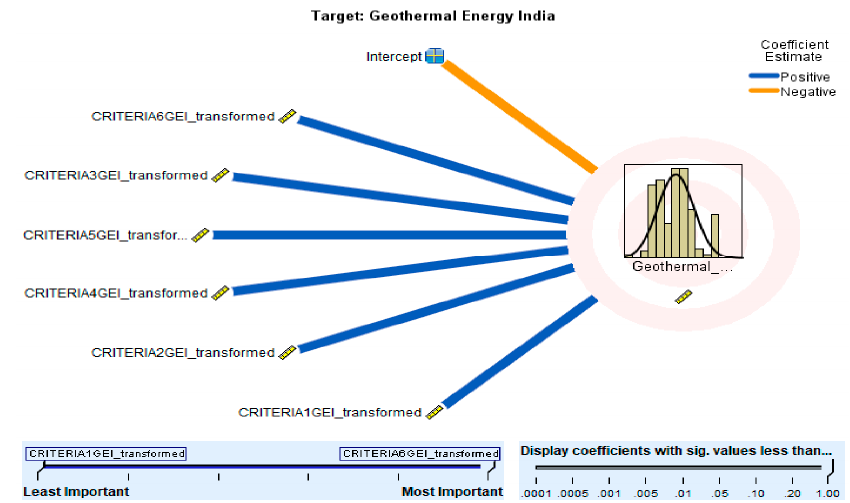
Figure 13. GE India GCV Criteria. Source: ALM Analysis SPSS by Author.